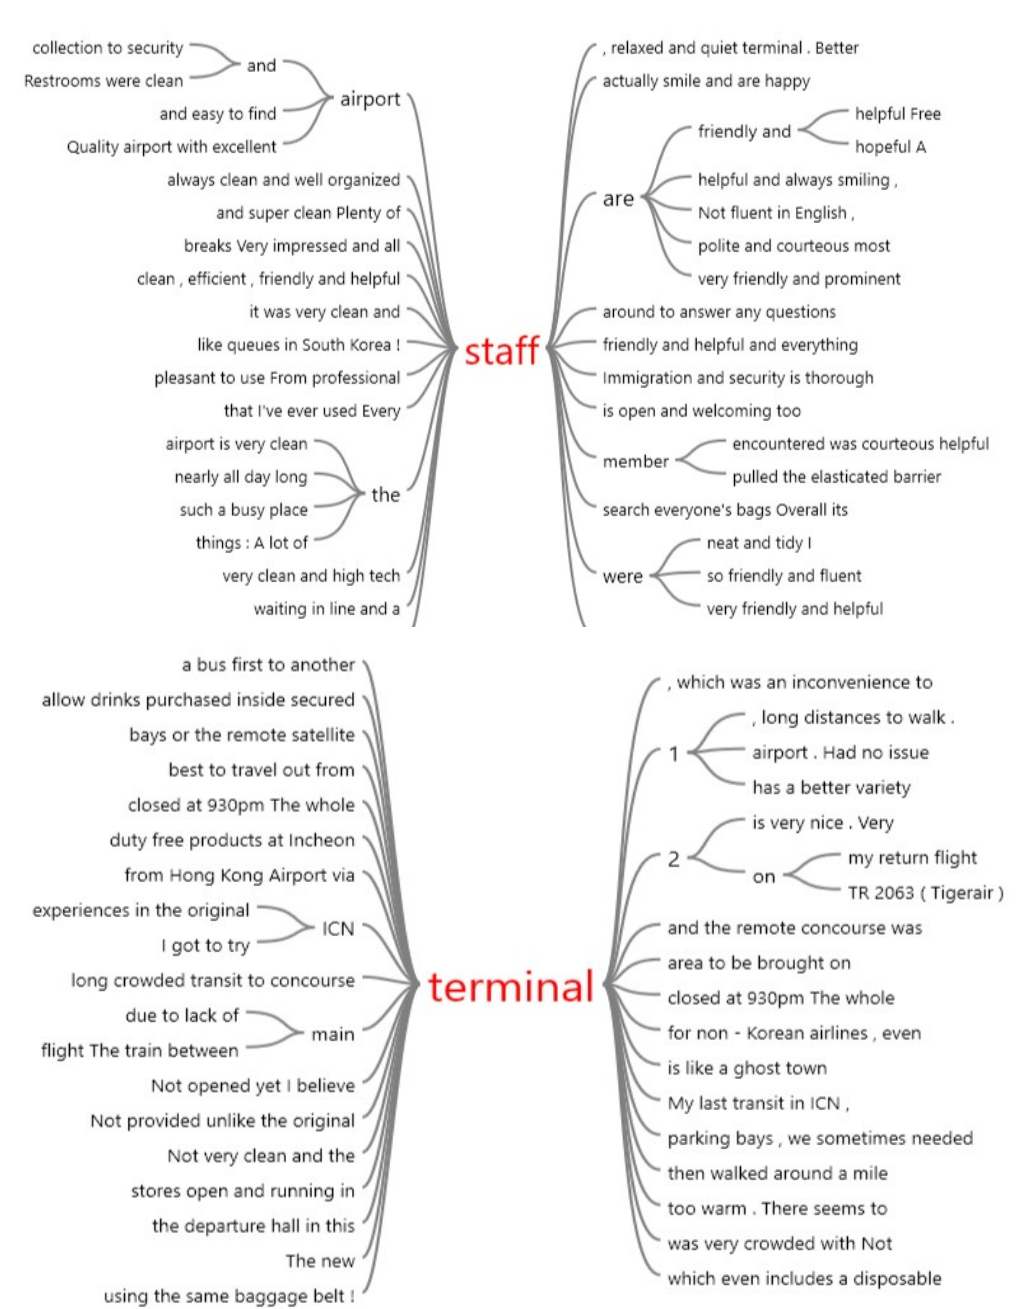
Figure 4. Word Trees “Staff” and “Terminal” for the World’s Leading Airports.